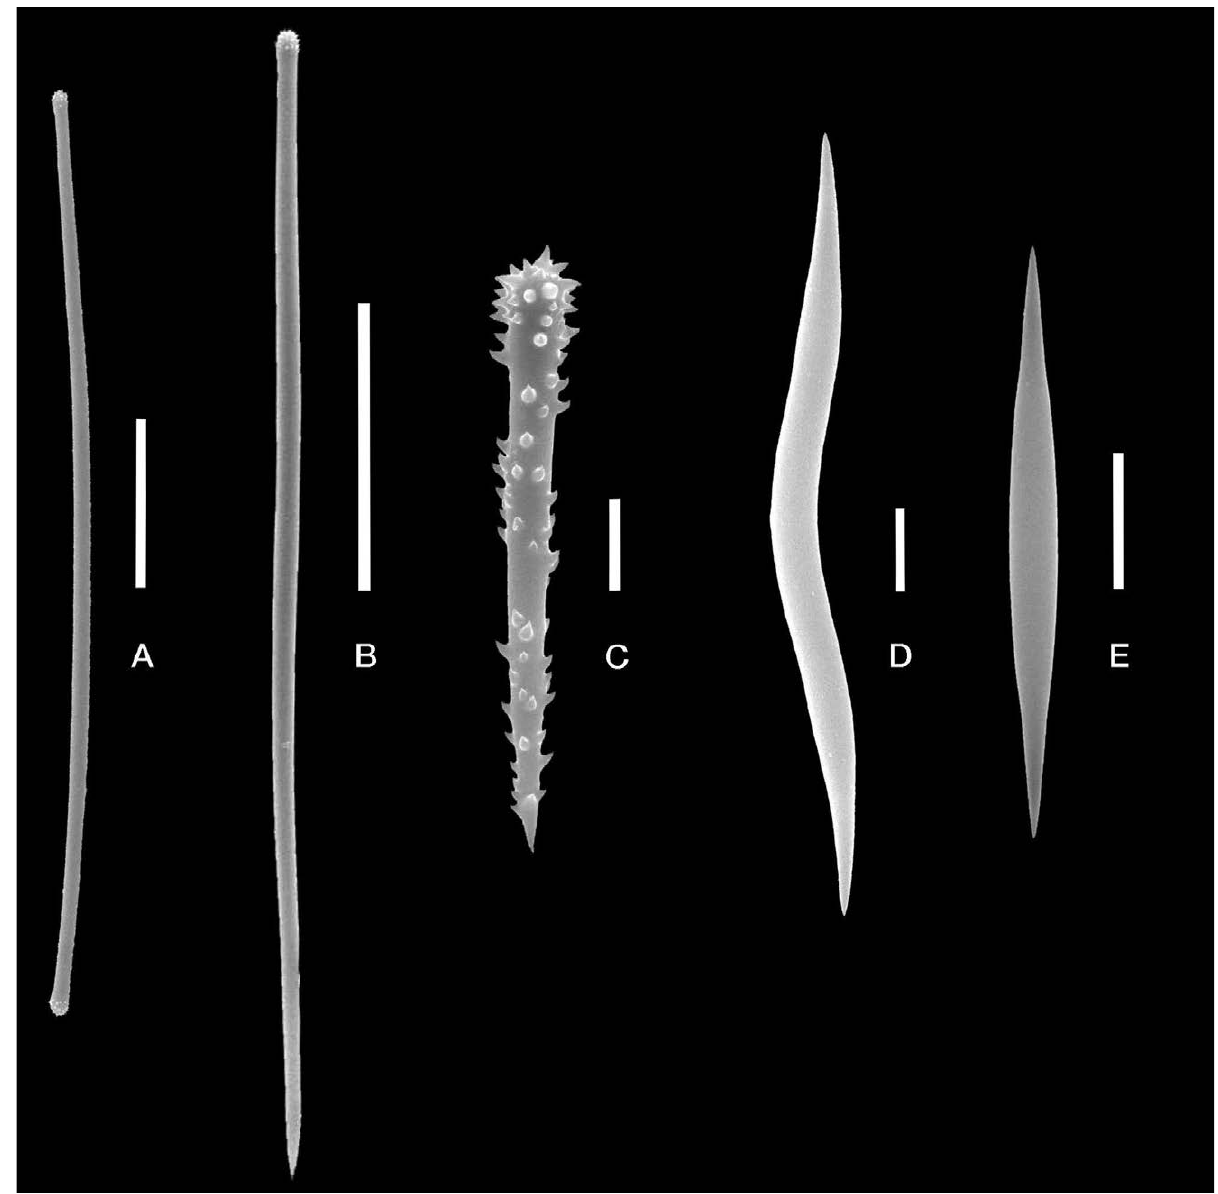
Fig . 8. – Acheliderma fulvum n. sp. A, Ectosomal tylote with microspined heads. B, Choanosomal style with microspined base. C, Echinating acanthostyle. D, V-shaped toxa. E, Microxea. Scale: A, 40 μm; B, 70 μm; C, 10 μm; D, 7.5 μm; E,